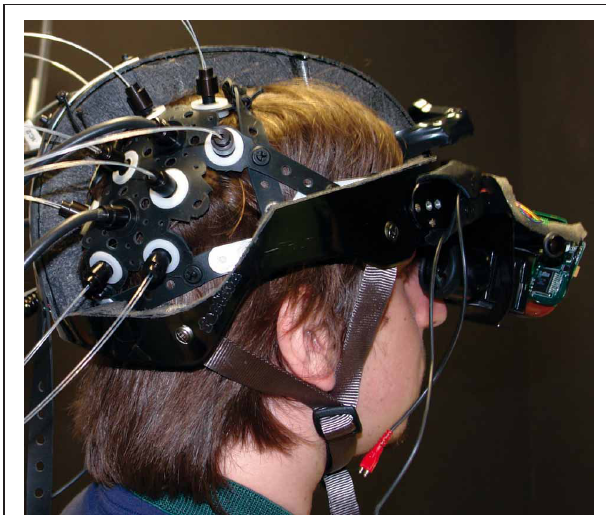
FIGURE 1 | The adapted virtual reality helmet. The helmet was created by attaching the LCDs removed from a V8 Research head mounted display to a modified bike helmet. The fNIRS optical fibers were applied to the parietal and occipital areas. A Velcro belt was attached at the back of the helmet in order to counterbalance the effect of the LCDs’ weight in front of the helmet. The belt was subsequently secured to the participants back through a thoracic belt.